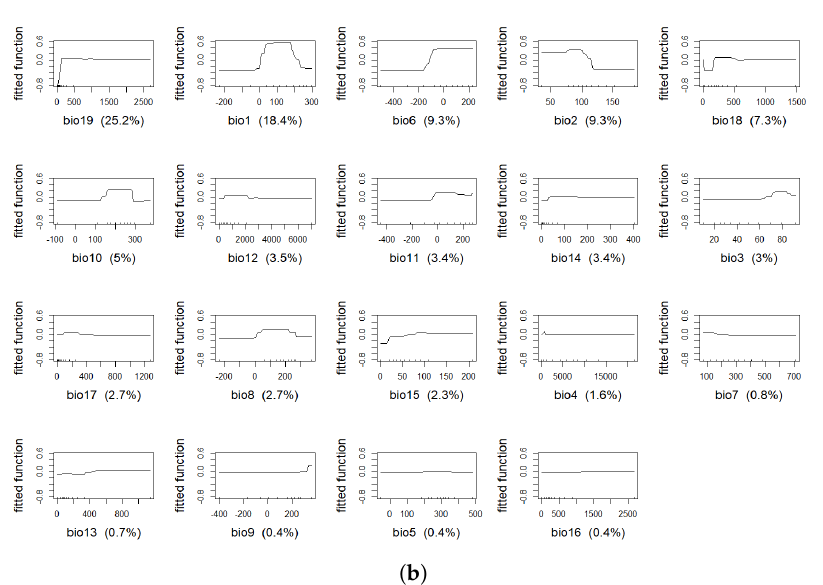
Figure A4. Response curves for the 19 predictors for BRT. ( a ) BTD data and ( b ) IBR data. The y-axis presents the predicted probability of the presence of BRD, and the scaled value for the predictors is presented on the x-axis ( ×